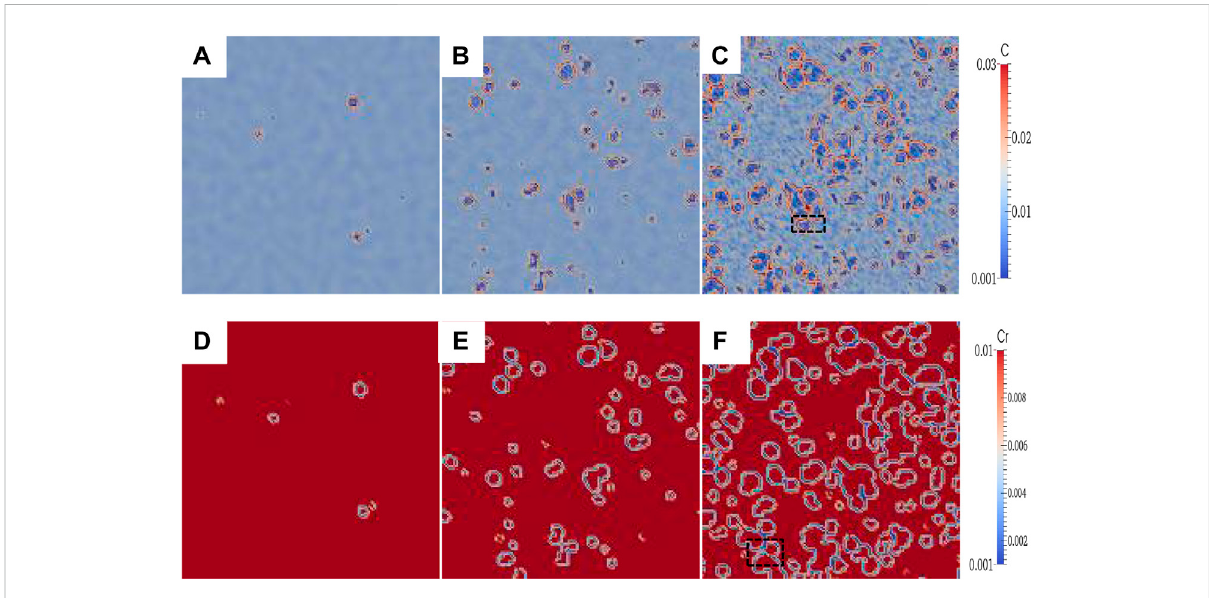
FIGURE 9 Evolution of the concentration fi eld with time based on 1,123 K. (A – C) C concentration fi eld; (D – F) Cr concentration fi eld. Dimensionless time: (a, d) t* = 14; (b, e) t* = 15; (c, f) t* =